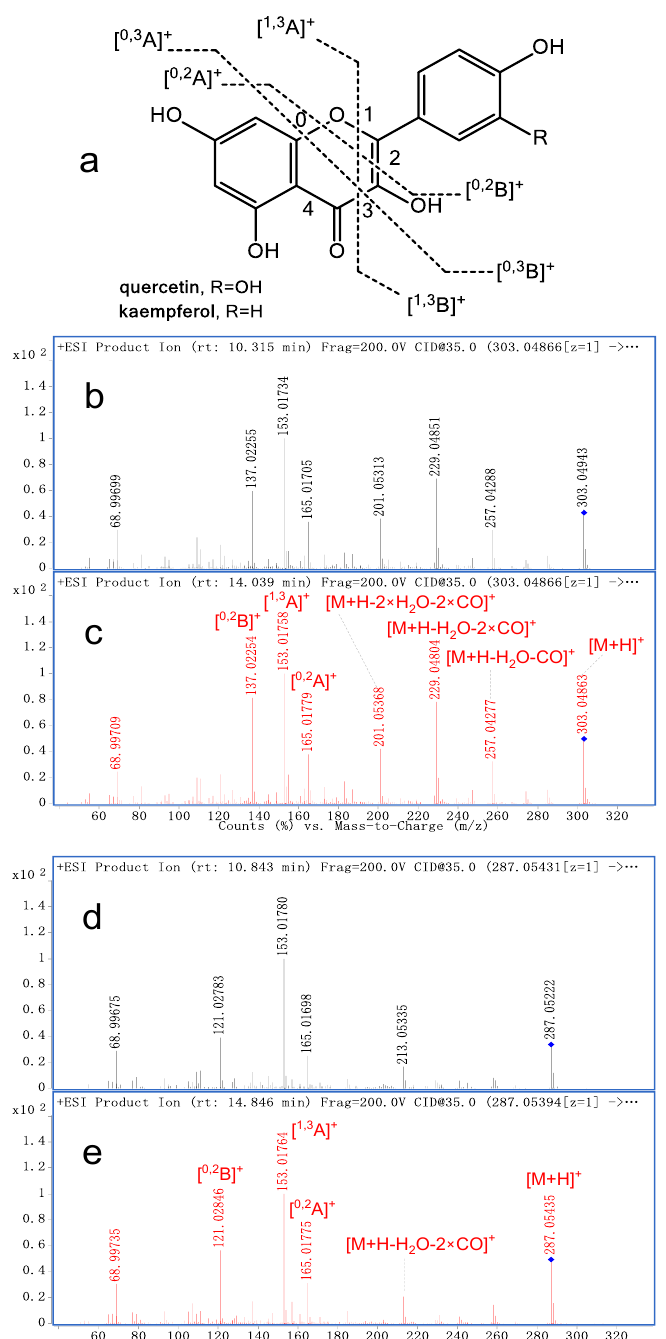
Figure 3. General nomenclature of the aglycone fragments ( a ); comparison of MS/MS spectrum be- tween potential quercetin skeleton ( b ) and authorized quercetin substance ( c ); comparison of MS/MS spectrum between potential kaempferol skeleton ( d ) and authorized kaempferol substance ( e ).